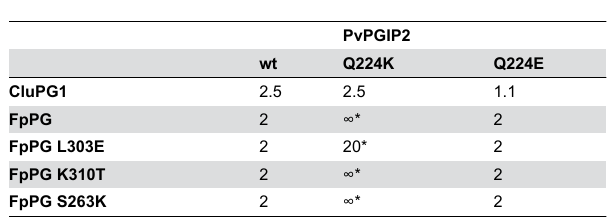
diffusion unit of the indicated PGs are shown. Asterisks indicate statistically significant differences, according to Student's t test (* P < 0.003). The symbol ∞ indicates > 1500 ng.